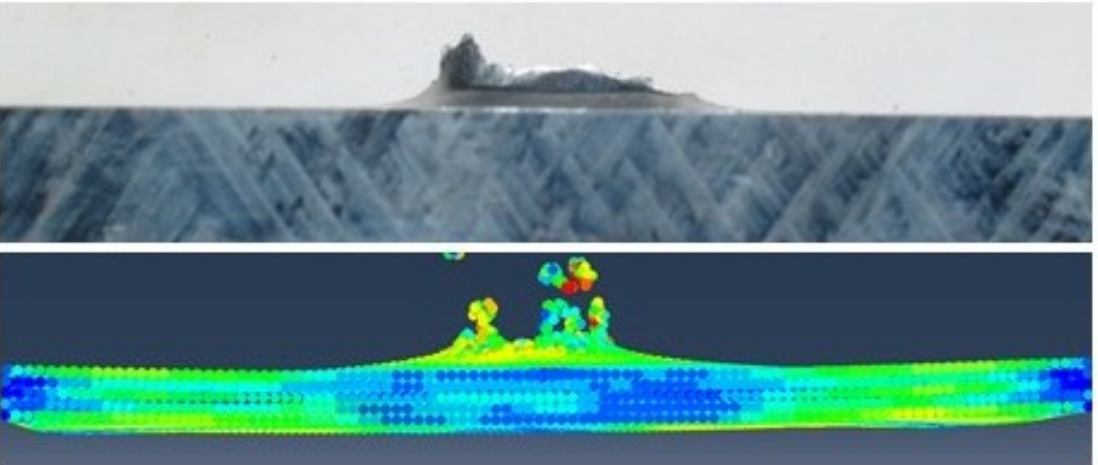
Figure 10. Visual Comparison of the Target with the Smoothed Particle Hydrodynamics